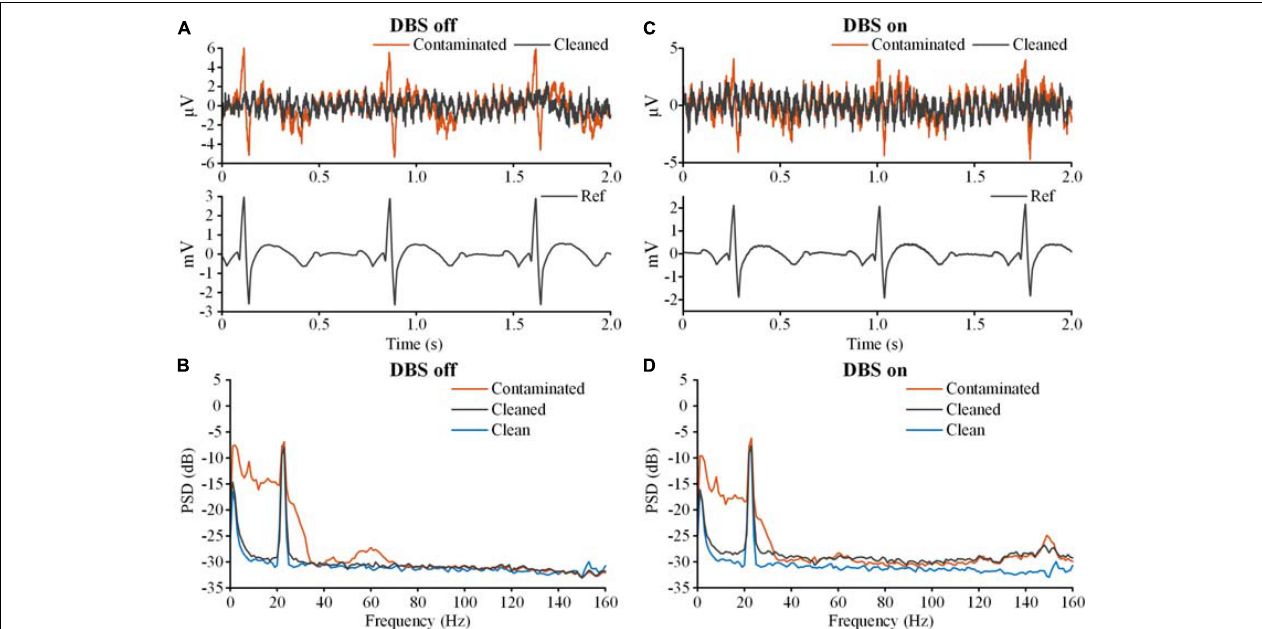
FIGURE 7 | The results of ECG artifact removal using adaptive filtering. (A) The results of ECG removal of the recording with the DBS off. The bipolar recordings before (contaminated, red line) and after (cleaned, gray line) ECG removal were plotted on the top axis. The monopolar recording of the ECG reference was plotted on the bottom axis. (B) The PSDs of the bipolar recording before and after ECG removal. The blue line is the PSD of the clean LFP. (C) The results of ECG removal from the recording with the DBS on. (D) The PSDs of the bipolar recordings before and after ECG